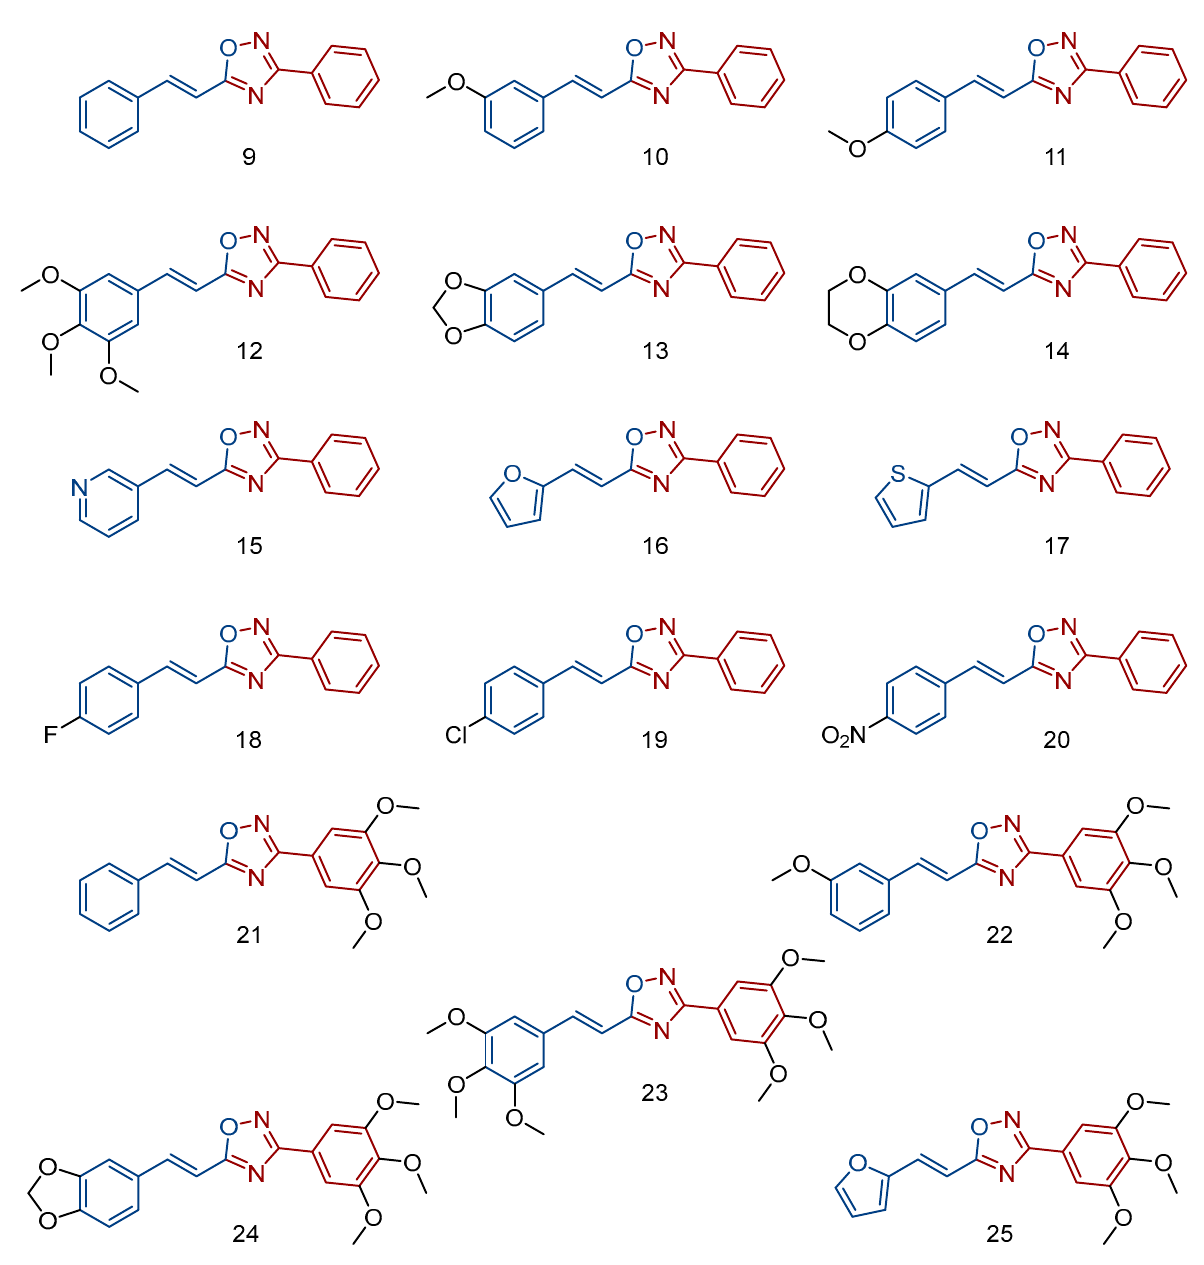
Figure 2. Chemical structures of ( E )-3-aryl-5-(2-aryl-vinyl)-1,2,4-oxadiazoles ( 9 – 25 ) planned for this work.